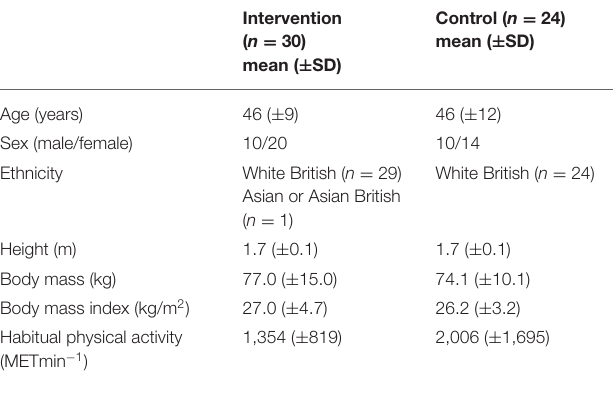
TABLE 3 | Baseline participant characteristics (mean ± SD).